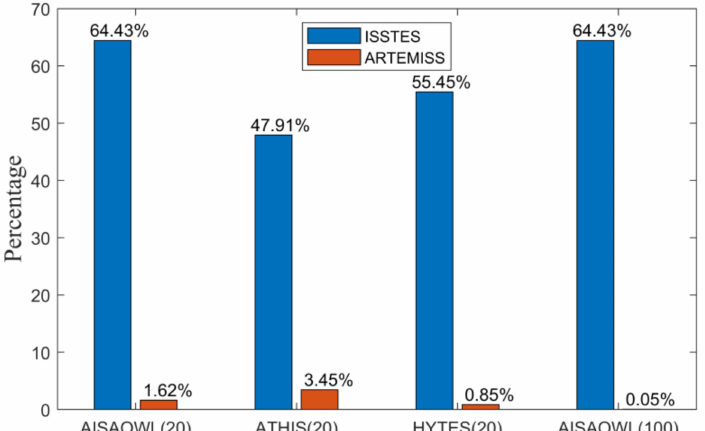
Figure 5. Percentage of the retrieval temperature error saturation phenomenon. The first three groups of bars are the percentages of the cases that the absolute value of retrieval LST error is 20 K in the retrieval results of ISSTES and ARTEMISS on AISAOWL (100 nm), ATHIS (50 nm) and HYTES (35 nm) data, respectively, when ∆ T s is set to [ − 20K, 20K]; the fourth group of bars are the percentages of the cases that the absolute value of retrieval LST error is 100 K in the retrieval results of the two algorithms on AISAOWL (100 nm) data respectively when ∆ T s is set to [ − 100 K, 100